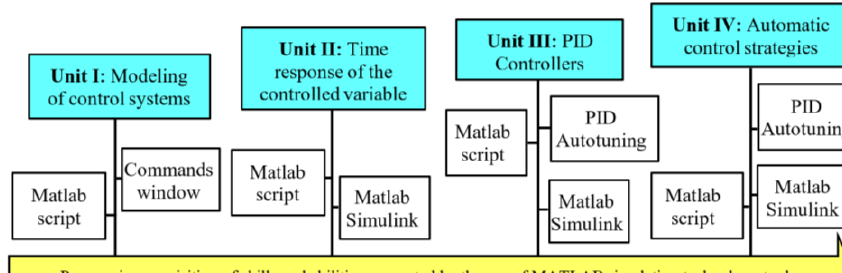
Fig. 1. Internment of thematic content and its progressive link with Matlab's technological simulation